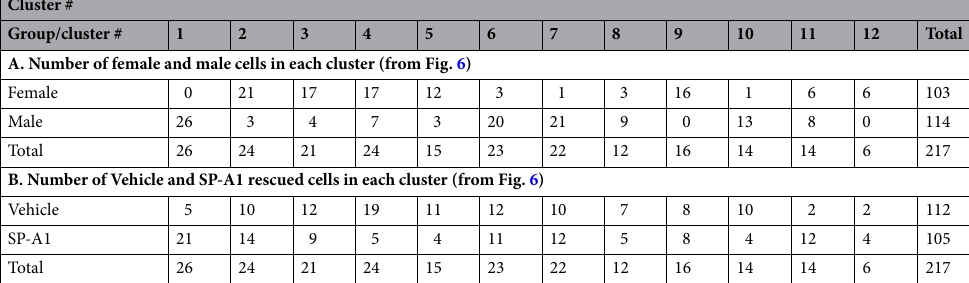
Table 5. Both sexes 12 clusters—7 markers (see Fig. 6). The table summarizes the details of a cluster analysis shown in Fig. 6 that includes the 217 cells used in this study. In Part A the number of cells in each cluster from male or female mice are listed. In Part B the cells making up each cluster are described by whether they are from Vehicle-treated or SP-A1-treated